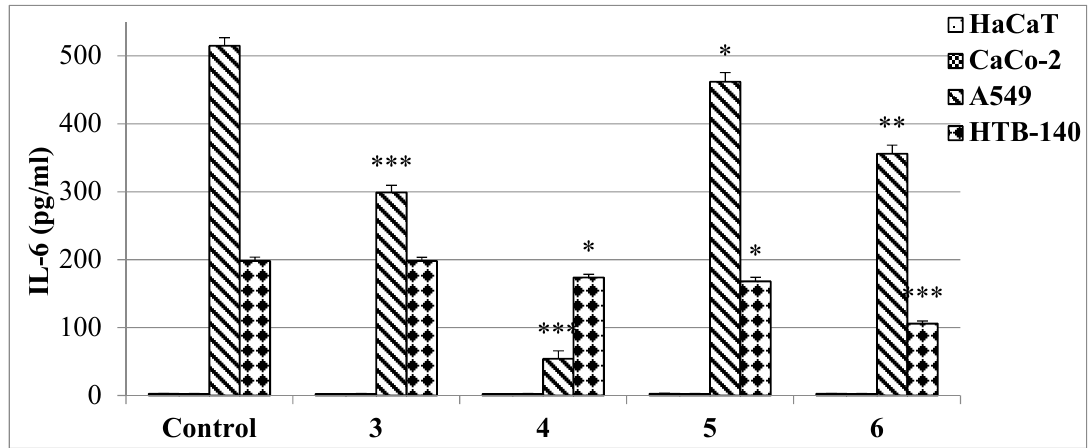
Figure 9. Effects of compounds 3 – 6 on IL-6 levels, measured by the ELISA test. Data are expressed as the mean ± SD from three independent experiments, performed in triplicate. *** p ≤ 0.001, ** p ≤ 0.01, * p ≤ 0.05, as compared to the control.